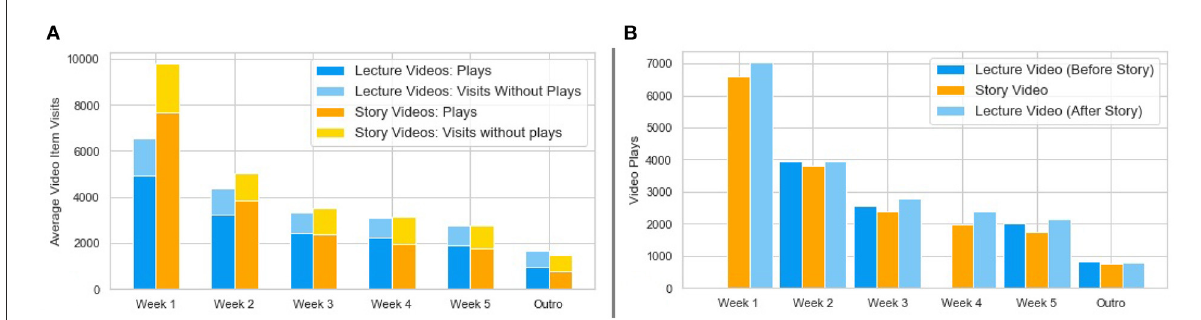
FIGURE4 Left (A) : Average number of video plays and visits without video plays for lecture and story videos per course week. On average, 29.7% of all lecture videos and 33.2% of all story videos were skipped. Story video plays are an absolute number, whereas for the lecture video plays, mean and standard deviation w i , i = { 1, ... ,6 } are as follows; w 1 : 4,954 (SD 1,063), w 2 : 3,223 (SD 460), w 3 : 2,407 (SD 264), w 4 : 2,249 (SD 136), w 5 : 1,916 (SD 205), w 6 : 962 (SD 150). Right (B) : Video plays of videos items directly before and directly after the story videos, listed per course week. On